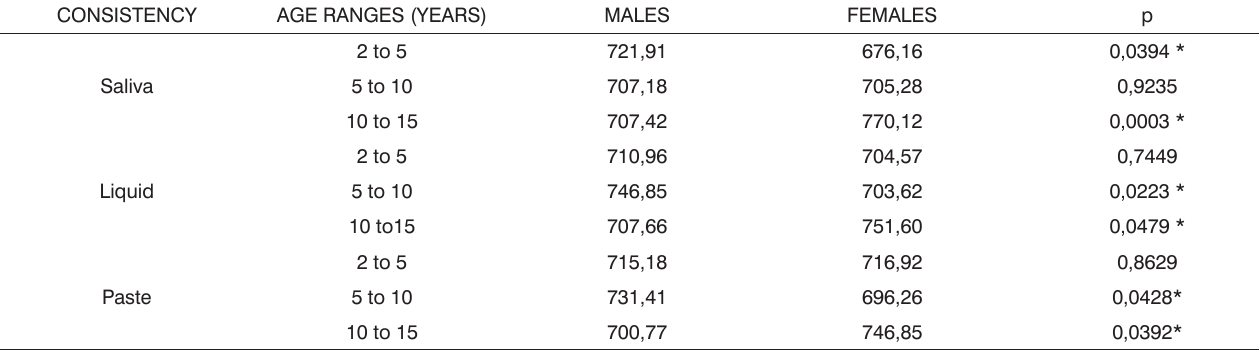
Table 1. Mean values and results from the tests comparing initial frequencies according to gender. CONSISTENCY